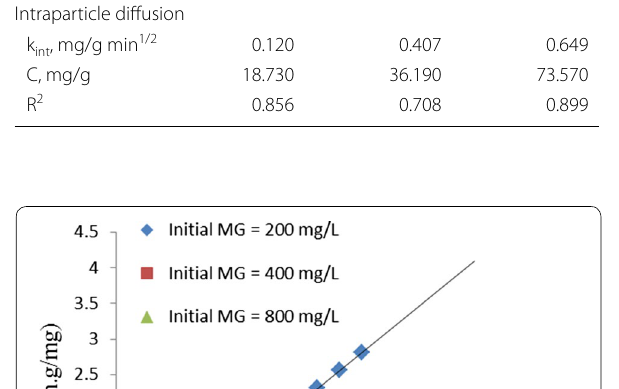
Fig. 9 Intraparticle diffusion kinetic plot for removal of MG by